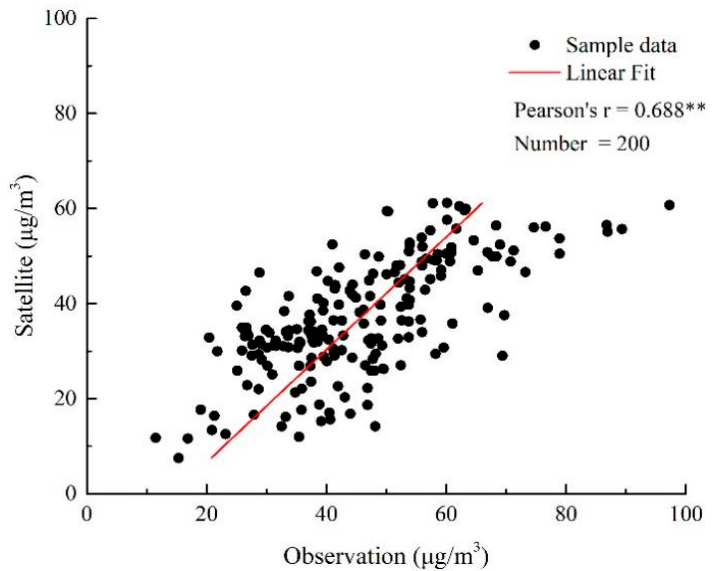
Figure 1. Scatter plot of observation data vs. satellite-retrieved PM 2.5 data. Note: ** indicate significance levels at 5% levels.